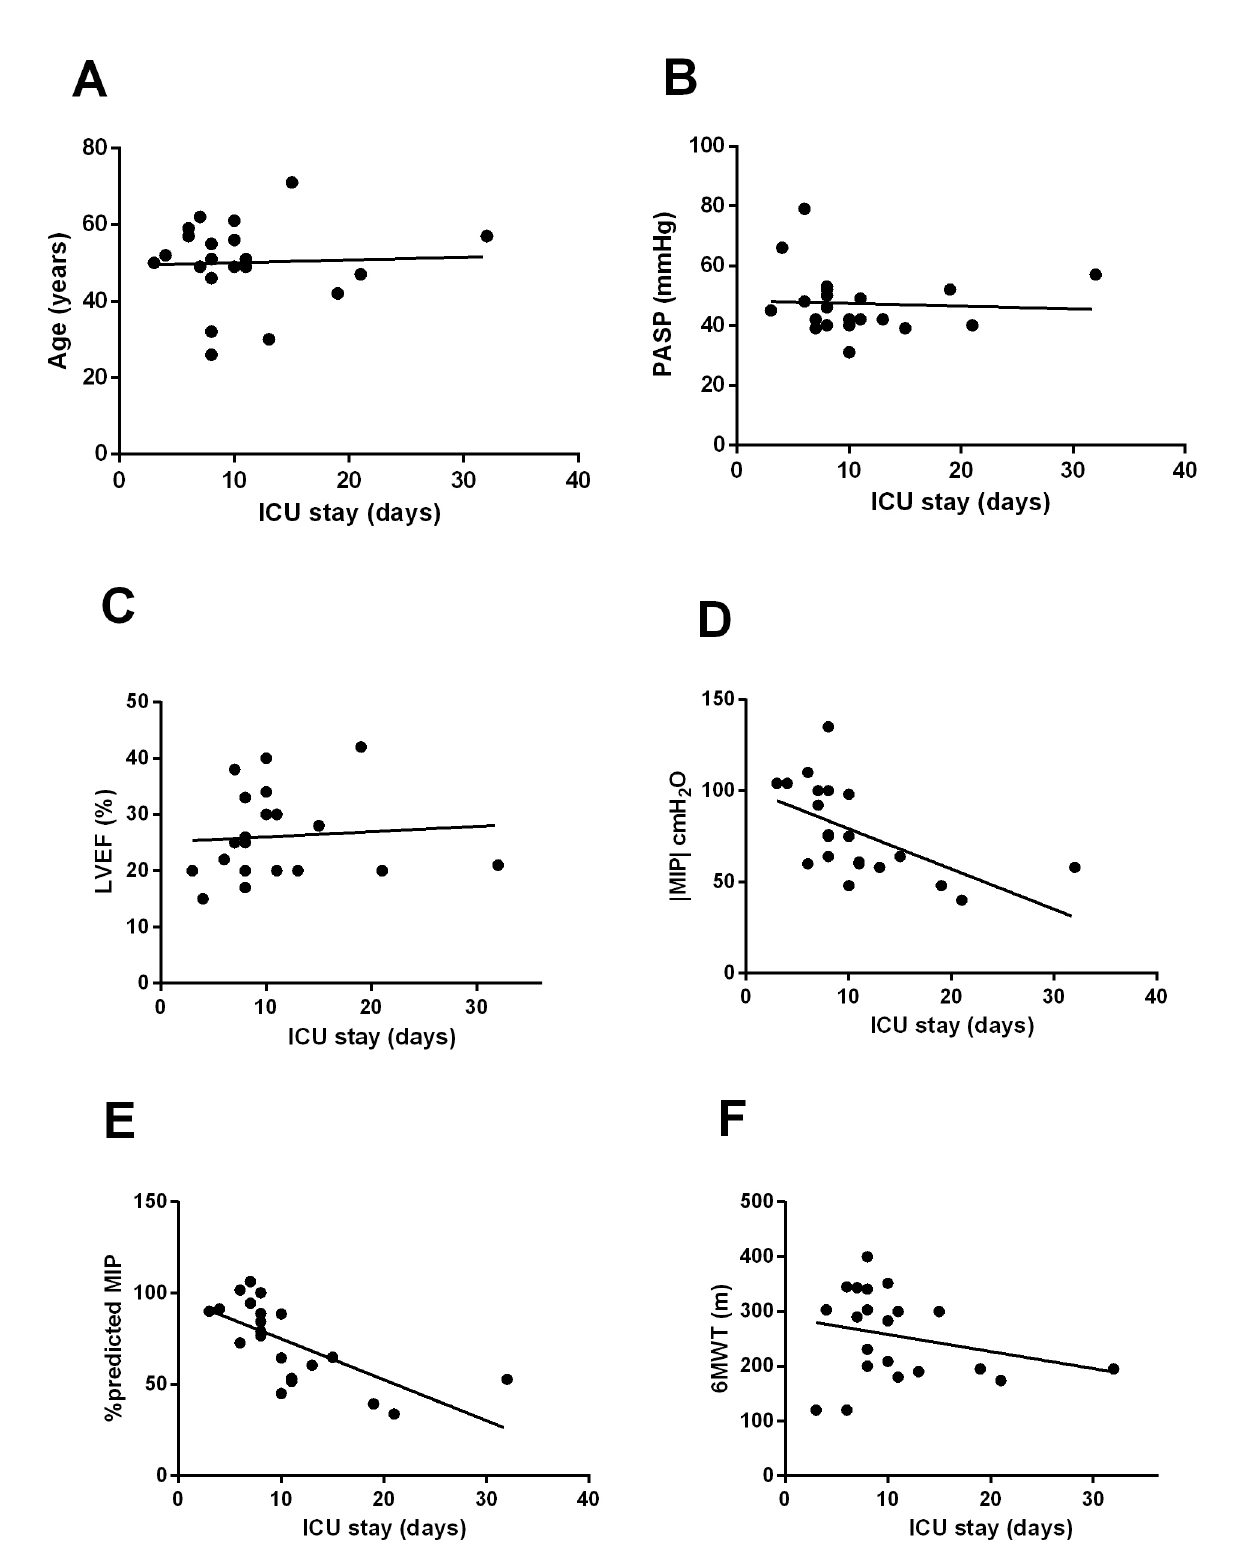
Fig. 3 - Clinical factors related to length of intensive care unit (ICU) stay. A. Age; B. pulmonary arterial systolic pressure (PASP); C. left ventricular ejection fraction (LVEF); D. maximal inspiratory pressure (MIP); E. percent-predicted MIP; F. six-minute walk test (6MWT)